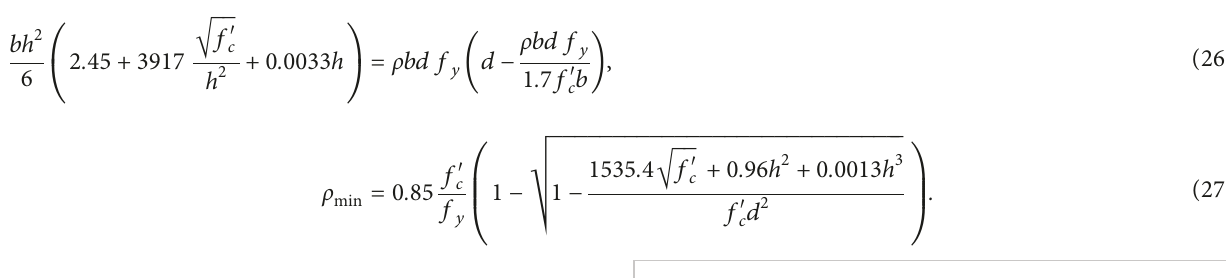
r ) comparing with codes of